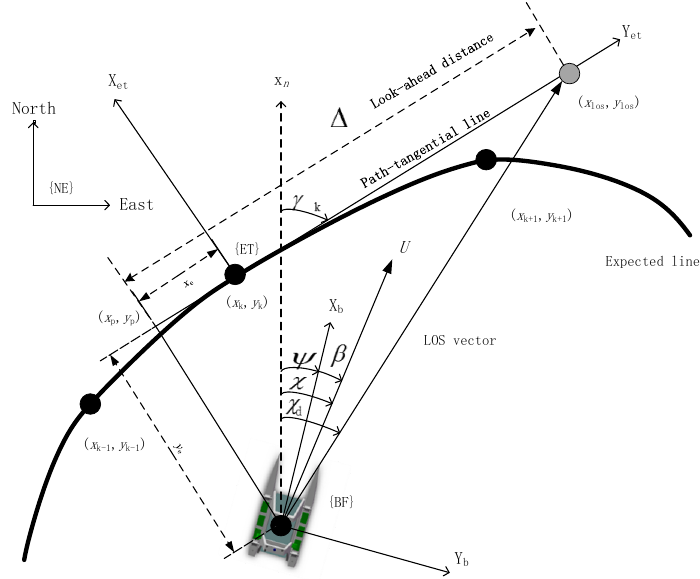
Figure 4. The reference frames of USV’s trajectory tracking.